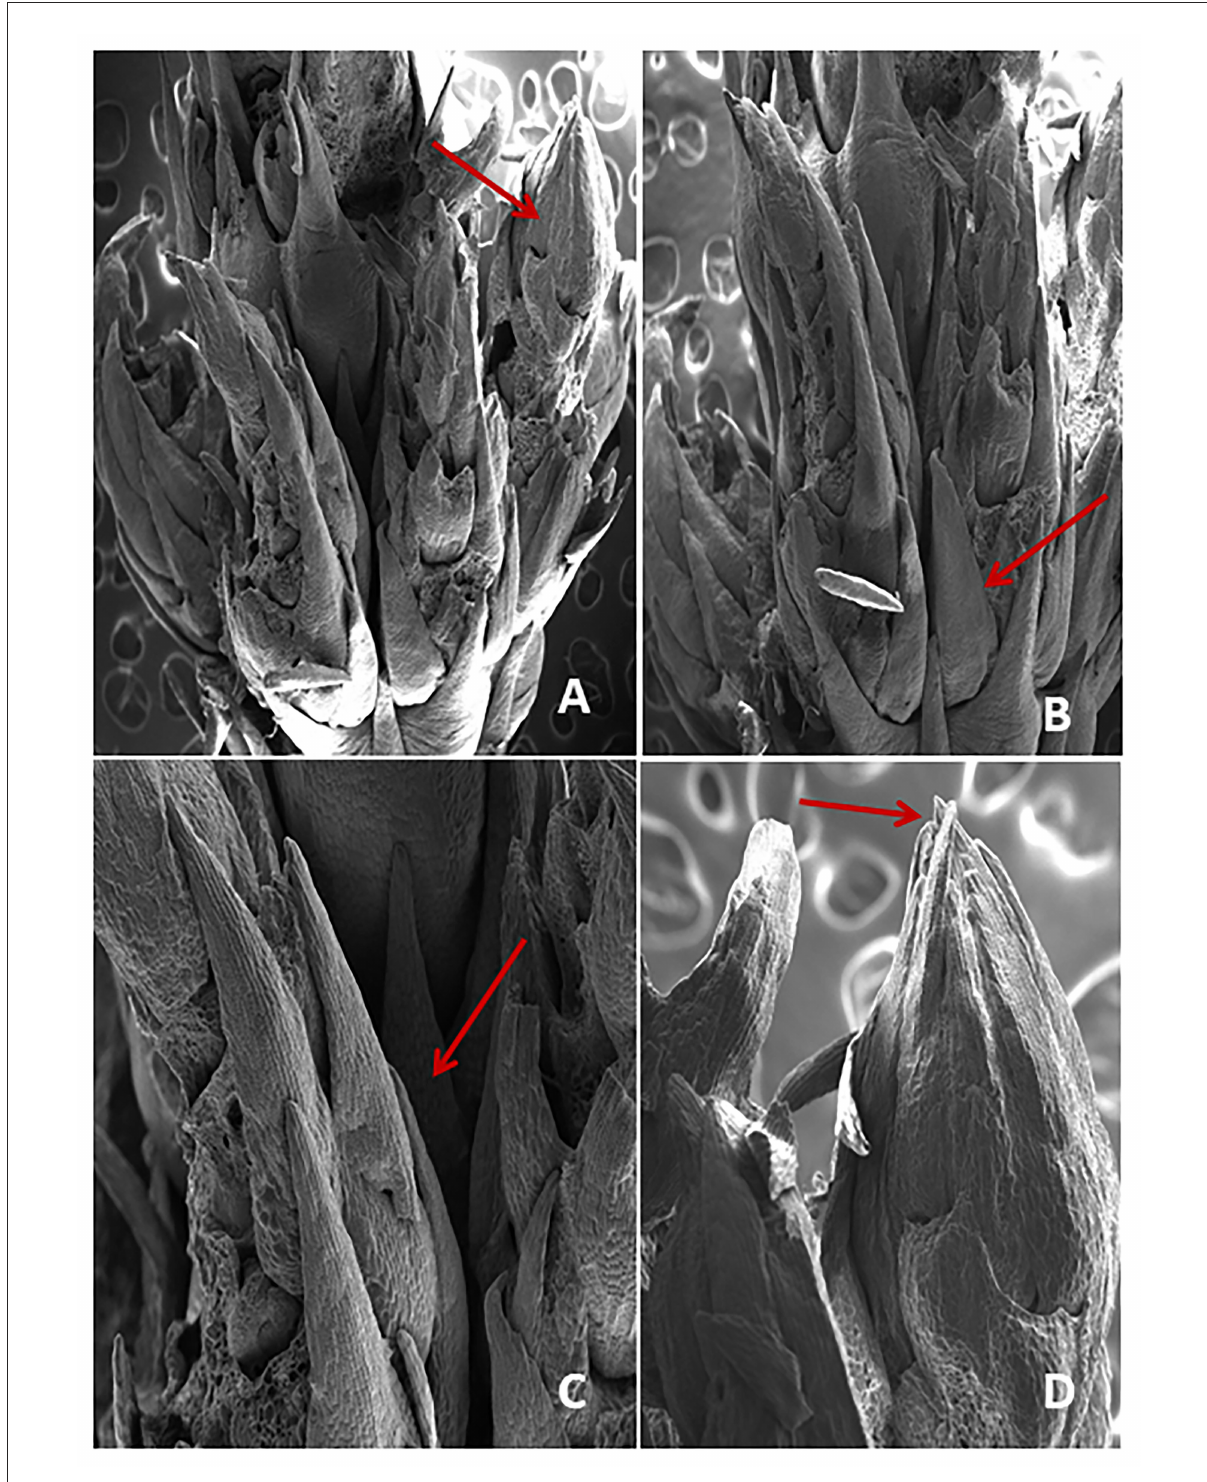
FIGURE4 (A–D) SEM examination showing the crown of direct shoot bud formation from the nodal region of explant